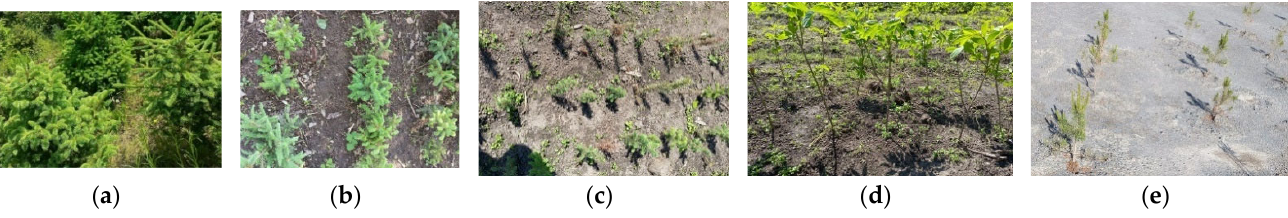
Figure 2. Images of five saplings: ( a ) large, ( b ) medium and ( c ) small spruce; ( d ) Manchurian ash; ( e ) Mongolian scotch pine.